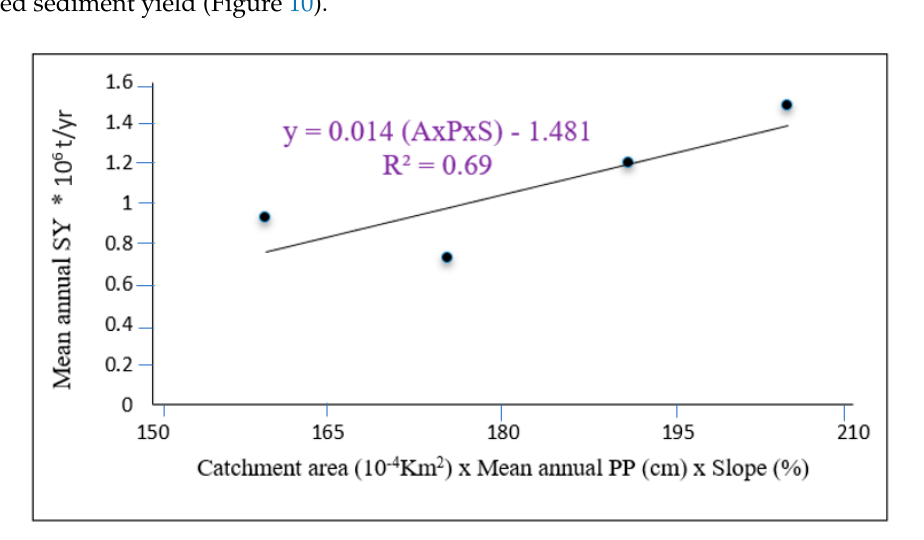
Figure 10. Relationship of mean annual SSY with the product of catchment area, slope, and average annual rainfall.